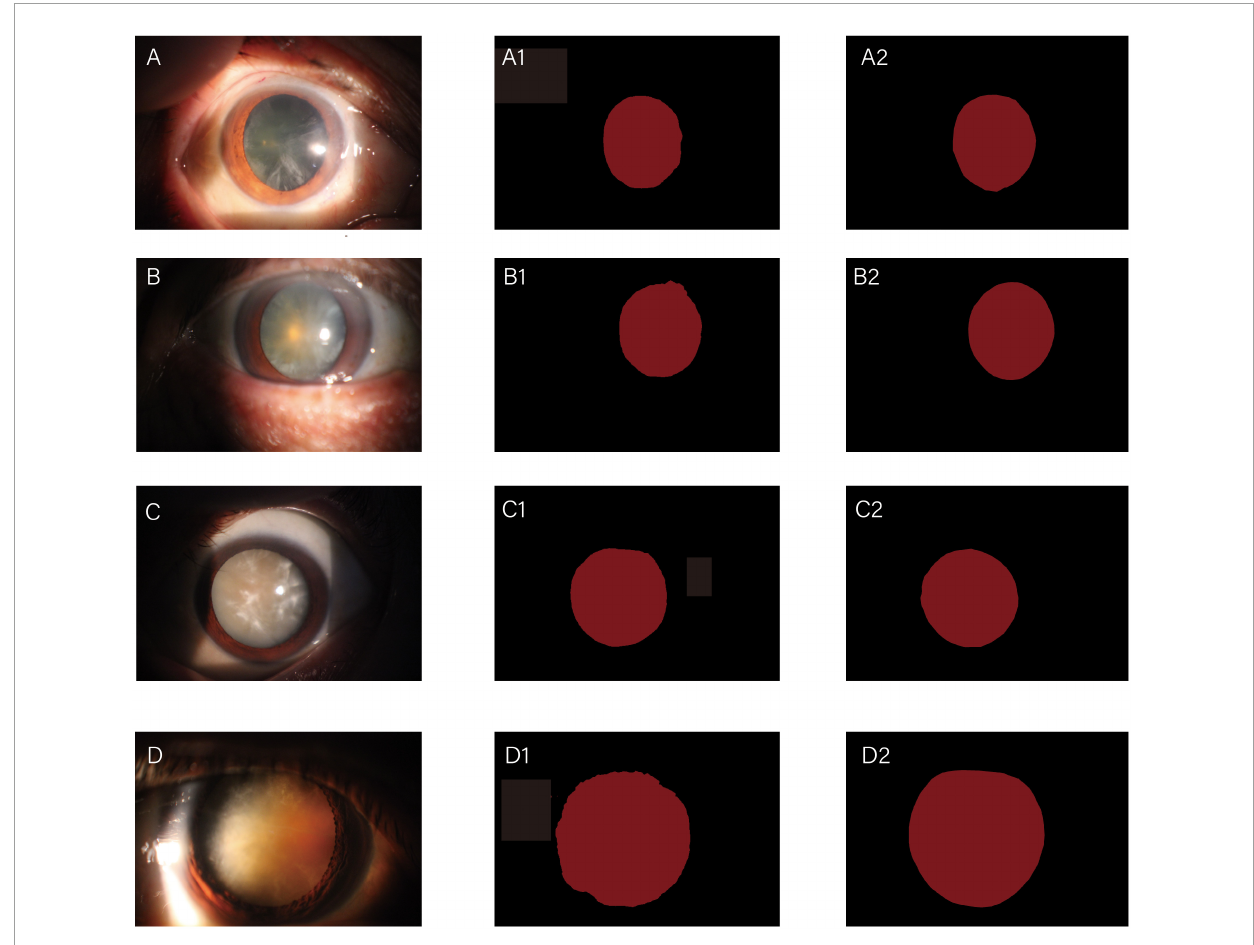
FIGURE2 Diagrams of comparisons between automatic and manual segmentation: original images of cataracts at different stage (A–D) ; the corresponding automatic segmentation mask (A1–D1) ; the corresponding manual segmentation mask (A2–D2)